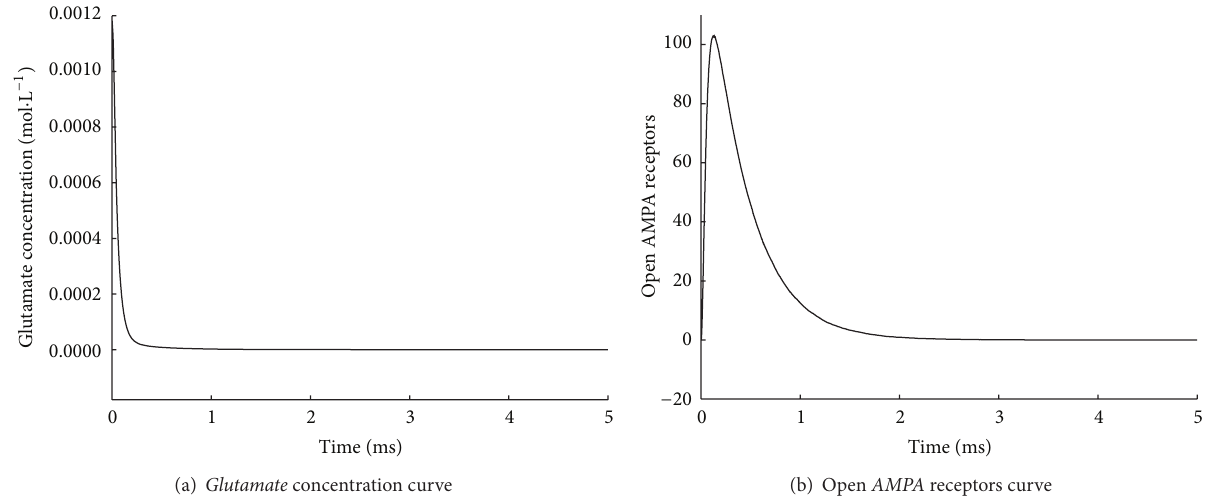
Figure 2: Examples of synaptic curves after a neurotransmitter vesicle release. (a) Variation of neurotransmitter (in this case glutamate ) concentration through time inside the synaptic cleft. (b) Variation in the total number of synaptic receptors (in this case AMPA ) in the open state through